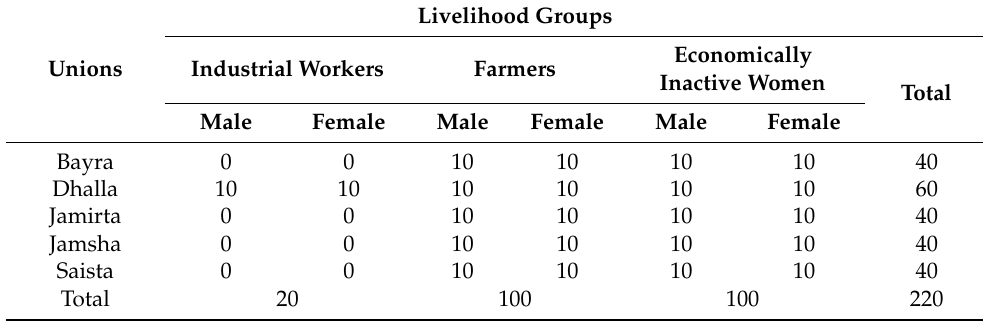
Table 3. Distribution of sample size in the household